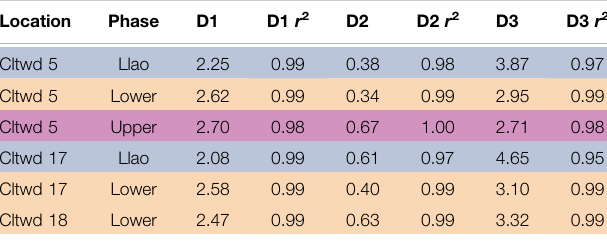
TABLE 1 | Fractal dimension values of cumulative grain-size distributions, D, for deposits present at locations Cltwd 5, 17 and 18 ( Figure 2 ; Figure 4 ), together with the r 2 value of the fi t. D1, D2, and D3 respectively correspond to the best fi ts of segments S1 ( < 0.125 mm), S2 (0.125 – 0.510 mm), and S3 ( > 0.510 mm) of the cumulative size distribution (see Figure 6B